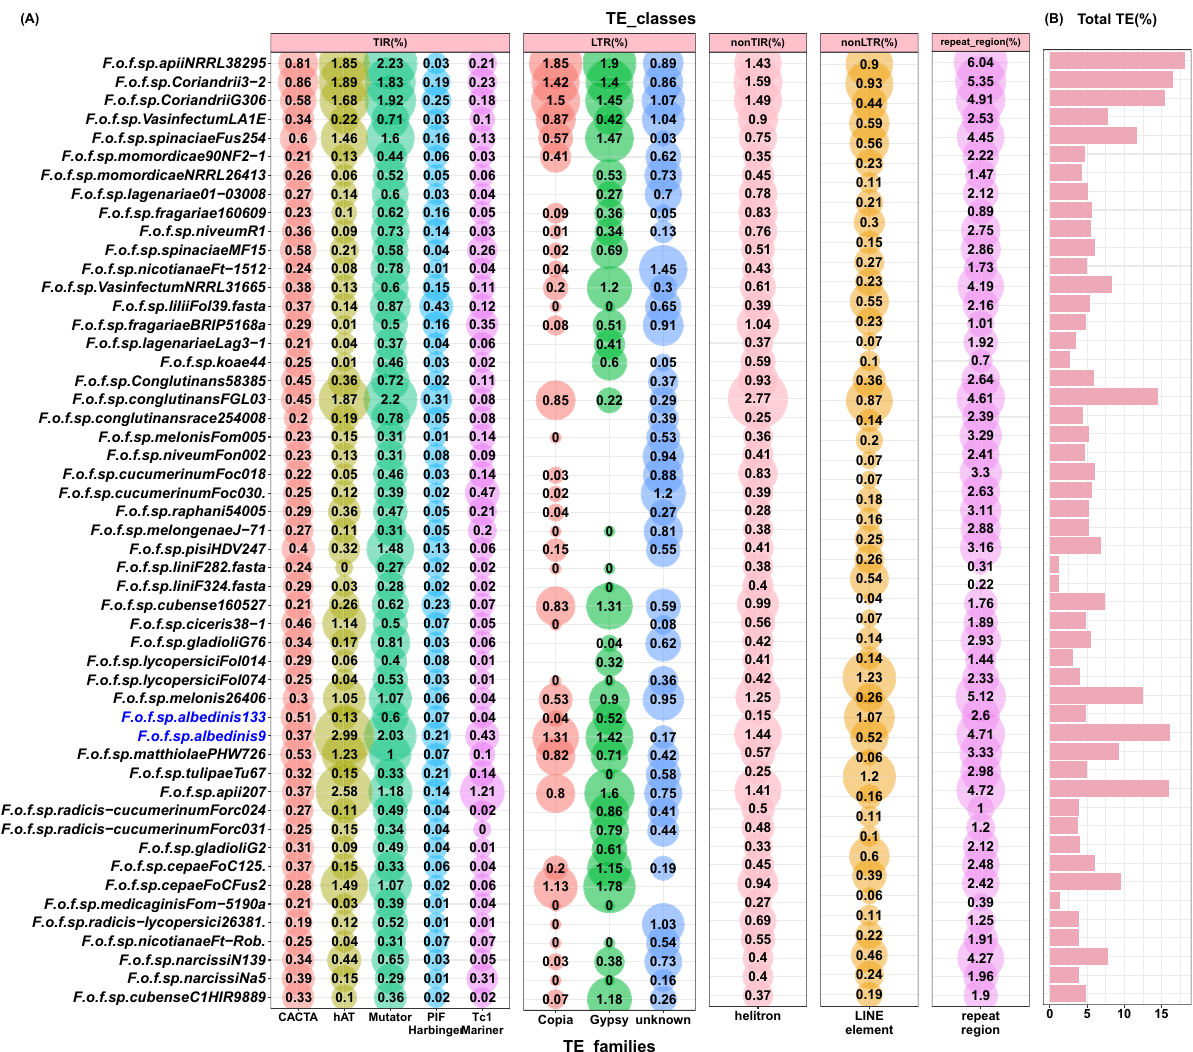
F.o.f.sp.pisiHDV247F.o.f.sp.melongenaeJ−71F.o.f.sp.raphani54005F.o.f.sp.cucumerinumFoc030.F.o.f.sp.cucumerinumFoc018F.o.f.sp.niveumFon002F.o.f.sp.melonisFom005F.o.f.sp.conglutinansrace254008F.o.f.sp.conglutinansFGL03F.o.f.sp.Conglutinans58385F.o.f.sp.koae44F.o.f.sp.lagenariaeLag3−1F.o.f.sp.fragariaeBRIP5168aF.o.f.sp.liliiFol39.fastaF.o.f.sp.VasinfectumNRRL31665F.o.f.sp.nicotianaeFt−1512F.o.f.sp.spinaciaeMF15F.o.f.sp.niveumR1F.o.f.sp.fragariae160609F.o.f.sp.lagenariae01−03008F.o.f.sp.momordicaeNRRL26413F.o.f.sp.momordicae90NF2−1F.o.f.sp.spinaciaeFus254F.o.f.sp.VasinfectumLA1EF.o.f.sp.CoriandriiG306F.o.f.sp.Coriandrii3−2F.o.f.sp.apiiNRRL38295 F.o.f.sp.cubenseC1HIR9889F.o.f.sp.narcissiNa5F.o.f.sp.narcissiN139F.o.f.sp.nicotianaeFt−Rob.F.o.f.sp.radicis−lycopersici26381.F.o.f.sp.medicaginisFom−5190aF.o.f.sp.cepaeFoCFus2F.o.f.sp.cepaeFoC125.F.o.f.sp.gladioliG2F.o.f.sp.radicis−cucumerinumForc031F.o.f.sp.radicis−cucumerinumForc024F.o.f.sp.apii207F.o.f.sp.tulipaeTu67F.o.f.sp.matthiolaePHW726F.o.f.sp.albedinis9F.o.f.sp.albedinis133F.o.f.sp.melonis26406F.o.f.sp.lycopersiciFol074F.o.f.sp.lycopersiciFol014F.o.f.sp.gladioliG76F.o.f.sp.ciceris38−1F.o.f.sp.cubense160527F.o.f.sp.liniF324.fastaF.o.f.sp.liniF282.fasta Figure 3. Distribution and coverage (%) of predicted TE in the analyzed formae speciales . ( A ): bubble plot showing the predicted TE distributed on five classes: Long Terminal Repeated retrotransposons (LTR); Terminal Inverted Repeats (TIR); non-TIR; non-LTR and other repeated regions. The bubble size is proportional to the coverage of each TE family (% indicated inside bubbles). ( B ): bar plot showing the total TE coverage per genome. Abbreviations: F ( Fusarium ); o ( oxysporum ); f ( forma e); sp (speciales ). The names following the abbreviations represent the names of the formae speciales ; the abbreviations coming after the names of the formae speciales correspond to the strains belonging to these formae speciales (F.o.f.sp. albedinis 133: Fusarium osysporum forma specialis albedinis Foa